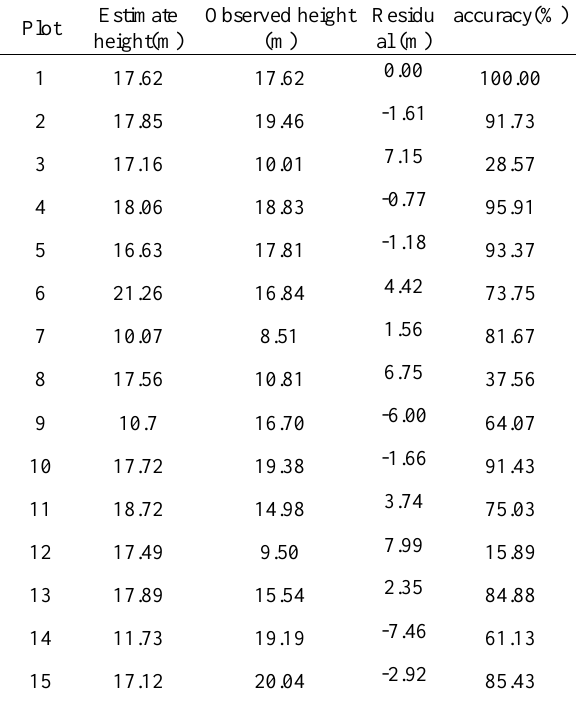
The result in Table4 shows the different planting distance competition index. Stand Competition Index 15 sample area